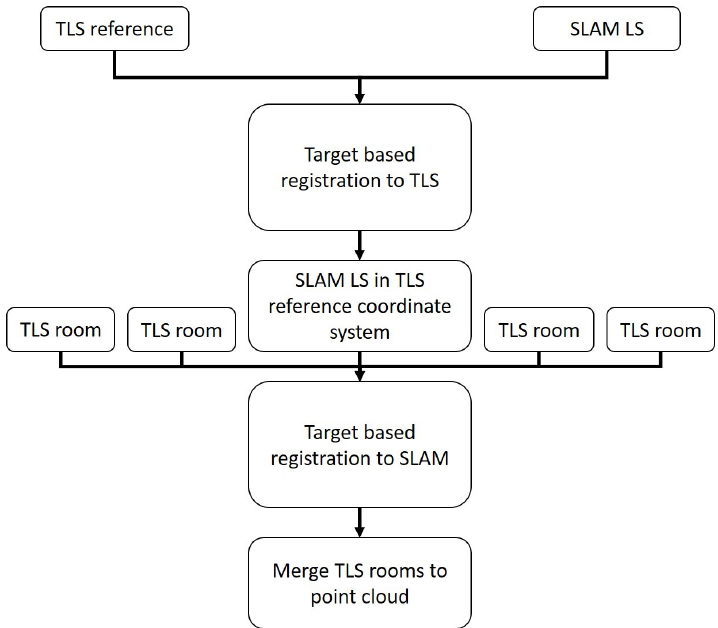
Figure 8. The process of registering the TLS point clouds of the rooms with the support of the SLAM LS point